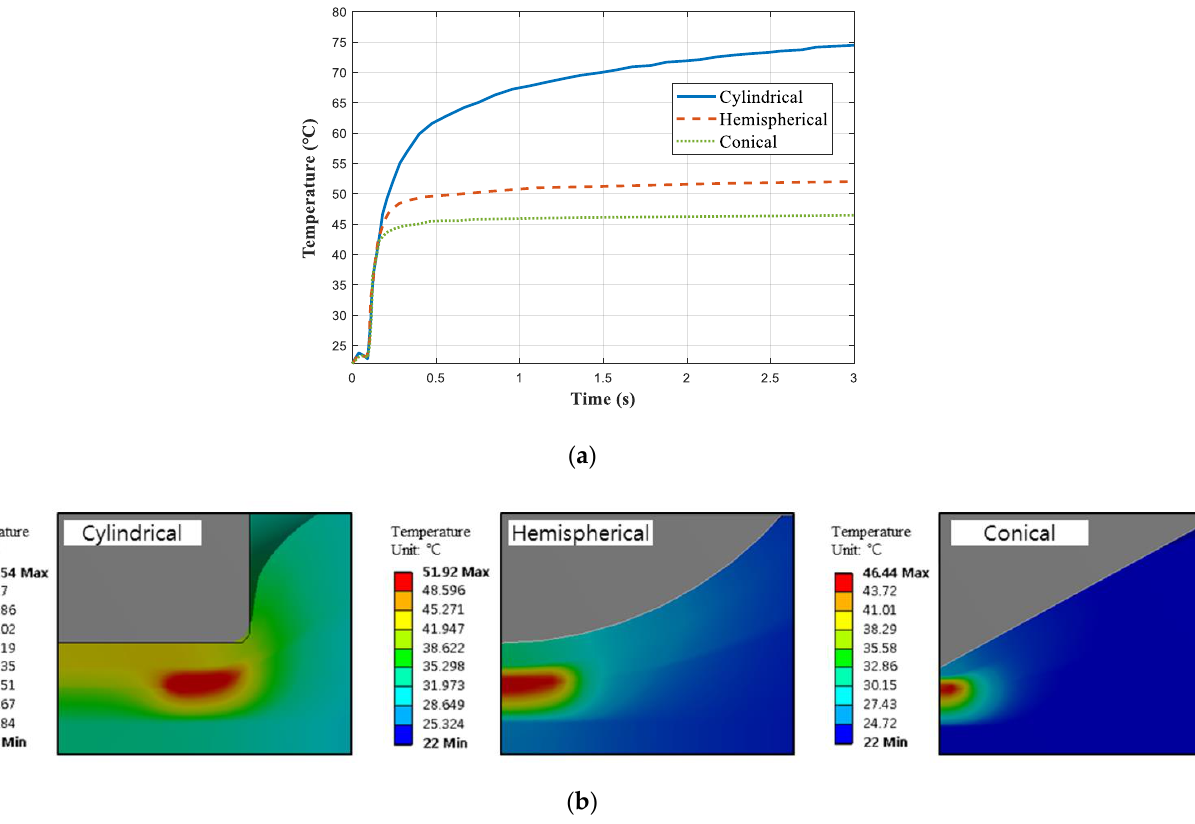
Figure 8. Comparison of thermal response for various indenters: ( a ) maximum temperature; ( b ) temperature distribution. Table 4. Thermal response of a LIB cell under various indenters.